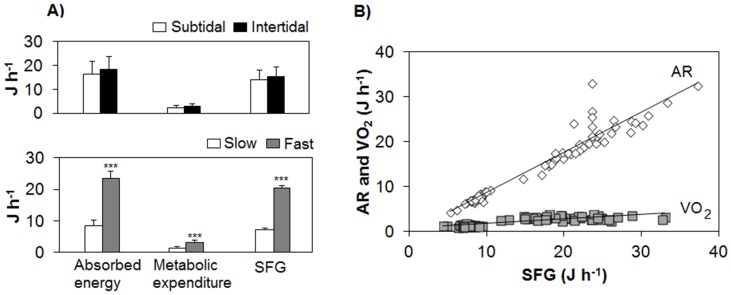
A) Comparison of the absorbed energy (AR = IR x AE), metabolic energy expenditure (oxygen consumption and ammonia excretion, M) and SFG of the two origins and growth groups of M. galloprovincialis. Statistical differences are indicated as *** for p<0.001 (two-way ANOVA). B) Absorption rate (AR: diamonds) and oxygen consumption (VO2: squares) at the different levels of Scope for Growth (SFG) obtained for intertidal and subtidal individuals after five months of maintenance with a monoalgal diet of Rhodomonas lens. Equations of regression lines fitted by least-squares to all the combined data are: AR = 0.89 SFG– 0.25 (R2 = 0.92) and VO2 = 0.10 SFG + 0.74 (R2 = 0.67).